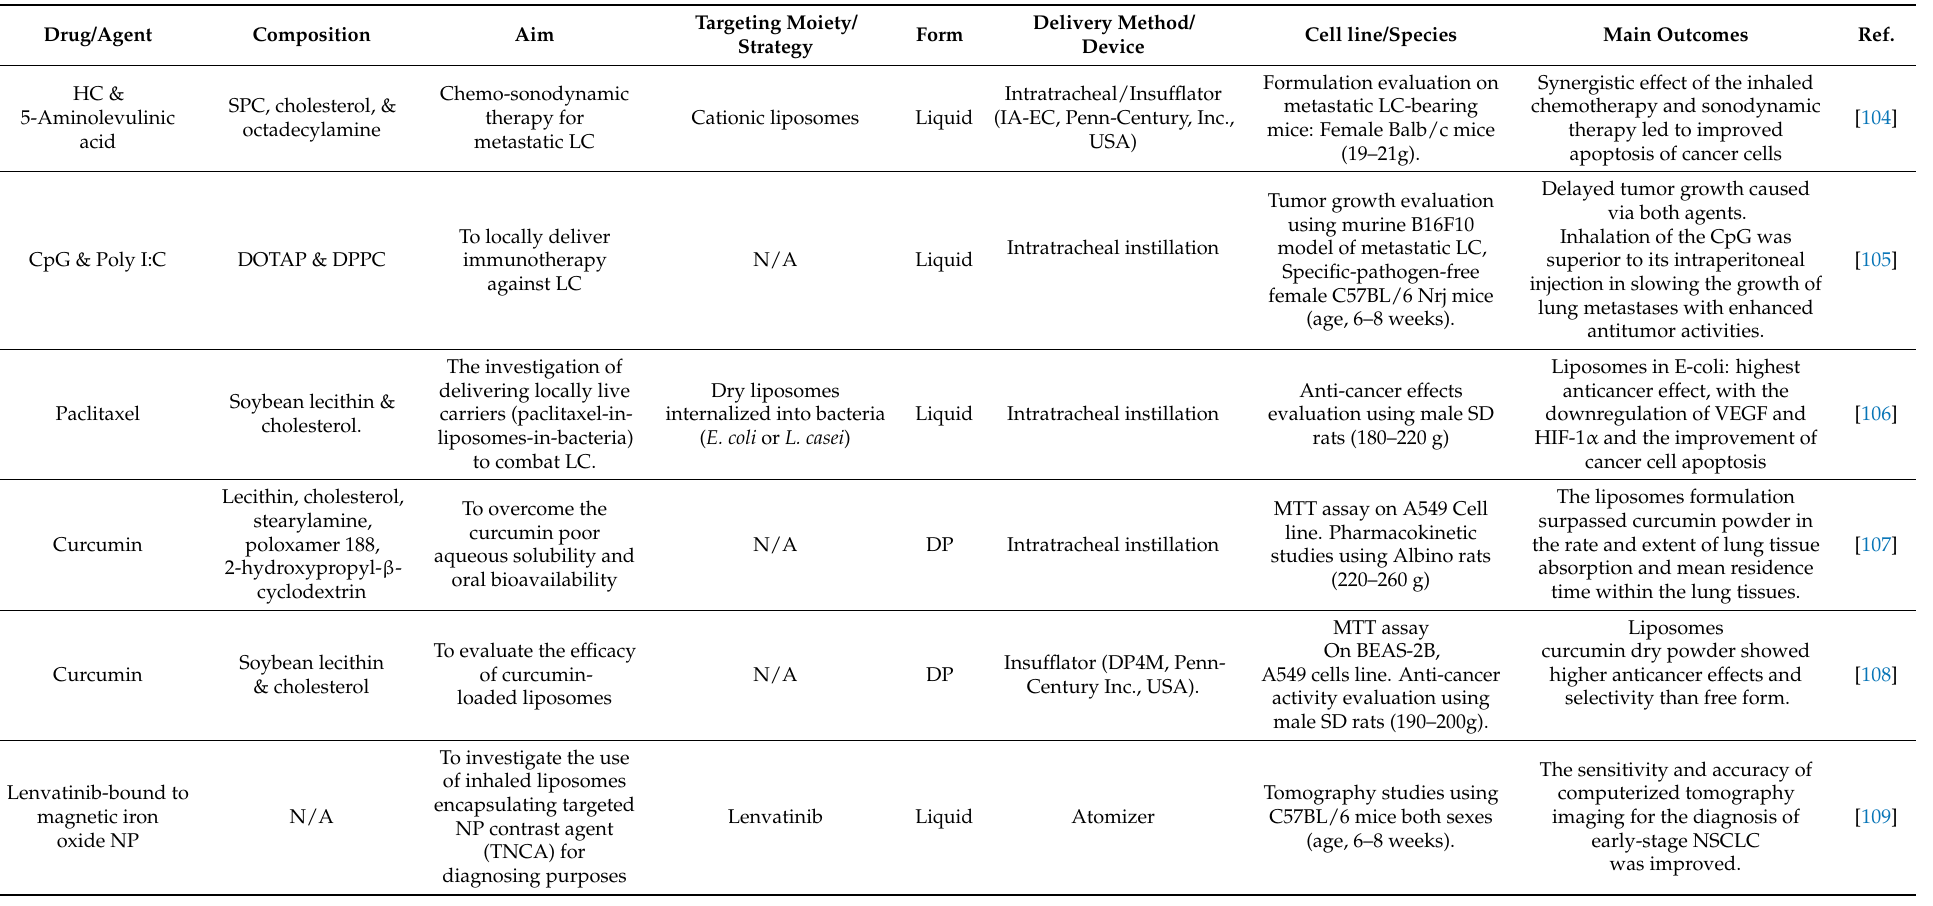
Table 1. Summary of the recently published in vivo studies about the inhalable anticancer drugs-loaded liposomal formulations for the treatment of